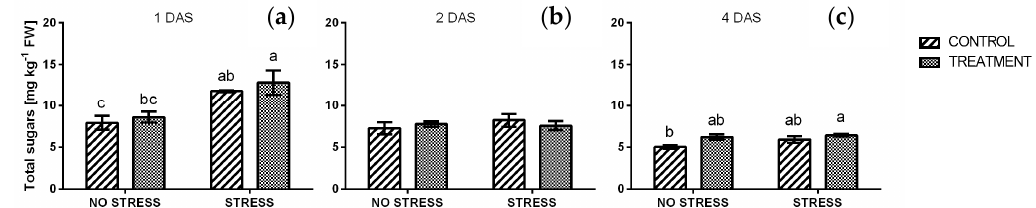
Figure 8. Reducing sugars concentration in rocket leaves treated with water (CONTROL) and with borage extract (TREATMENT) and subjected to salt stress for 24 h. Measures were taken after one day ( a ), two days ( b ) and four days ( c ) of stress. Values are means ± SE ( n = 4). Data were subjected to two-way ANOVA. Different letters, where present, represent significant differences ( p < 0.05).